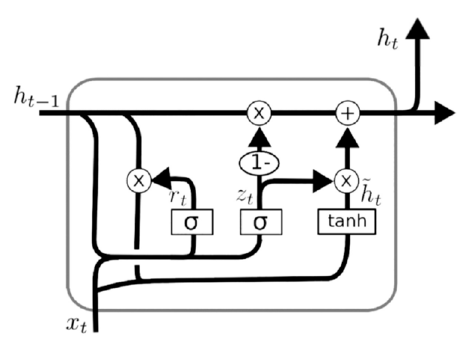
Figure 2 . The architecture of the Gated Recurrent Unit . Figure 2. The architecture of the Gated Recurrent